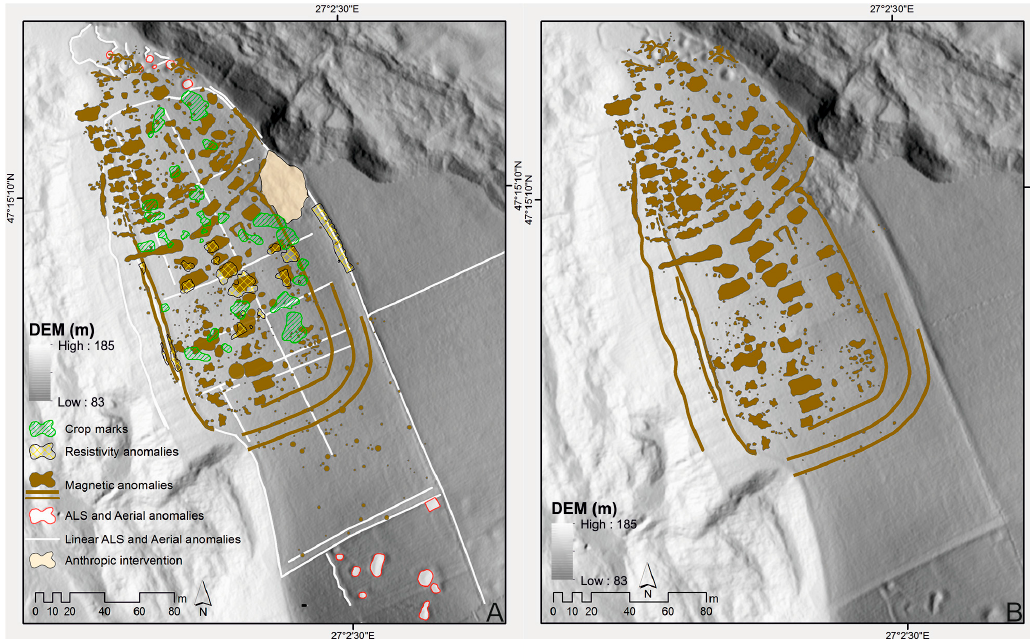
Figure 14. The final integrated interpretation: ( A ) Distribution within the study area of all anomalies identified using the array of techniques employed; ( B ) Distribution of anomalies regarded as belonging to the Eneolithic settlement.